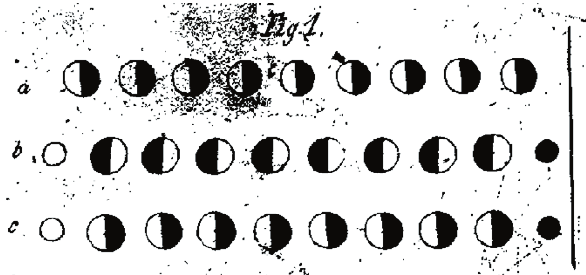
Figure 1. Hittorf´s concept and determination of the relative velocities and the transference numbers for the case that anions and cations have equal migration velocities. Anions: black semi- circles; cations: open semicircles. In solution, the ions are present in pairs as macroscopically uncharged molecules, since all ions unite with their oppositely charged ions by electrostatic attraction. There are no free ions present. Row a : When an electric potential is applied, the molecules are aligned in the direction of their respec- tive electrodes. Row b : The molecules are split into their ions, which migrate towards their corresponding electrodes, but reassemble with the oppositely charged ions in their immediate vicinity to form new molecules. Row c : The molecules rotate 180° to take the proper position in the field. Details can be found in the text. The figure is reproduced from Hittorf´s publication from 1853 (ref. [36] , Plate II, after p. 352).